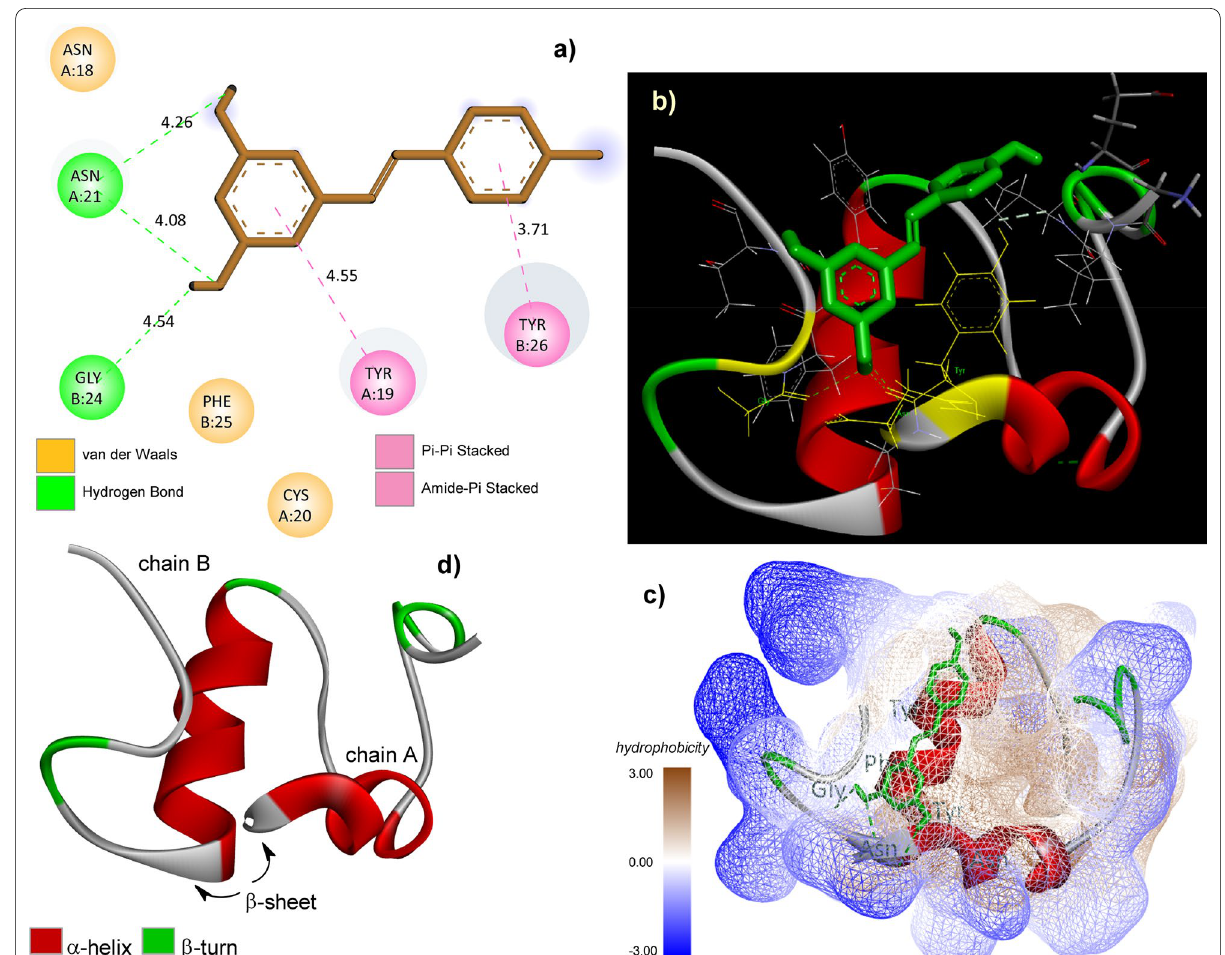
Fig. 7 Visualization of a binding residue INS‑RSV, b binding residue with insulin secondary structure, c binding site INS‑RSV with hydrophobicity surface region, and d secondary structure of insulin